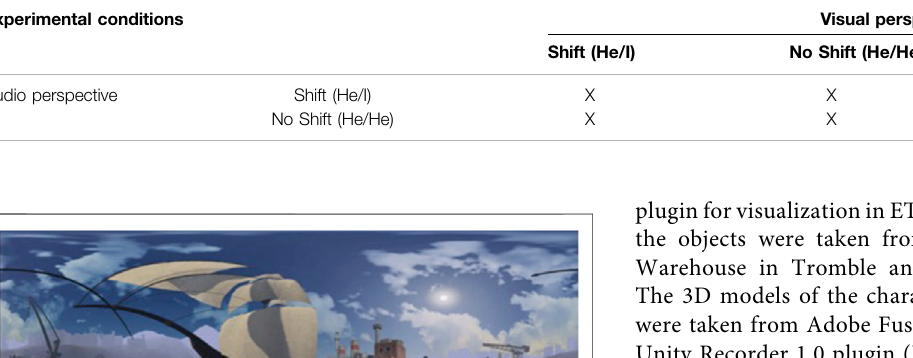
TABLE 1 | Presentation of the six experimental conditions crossing.